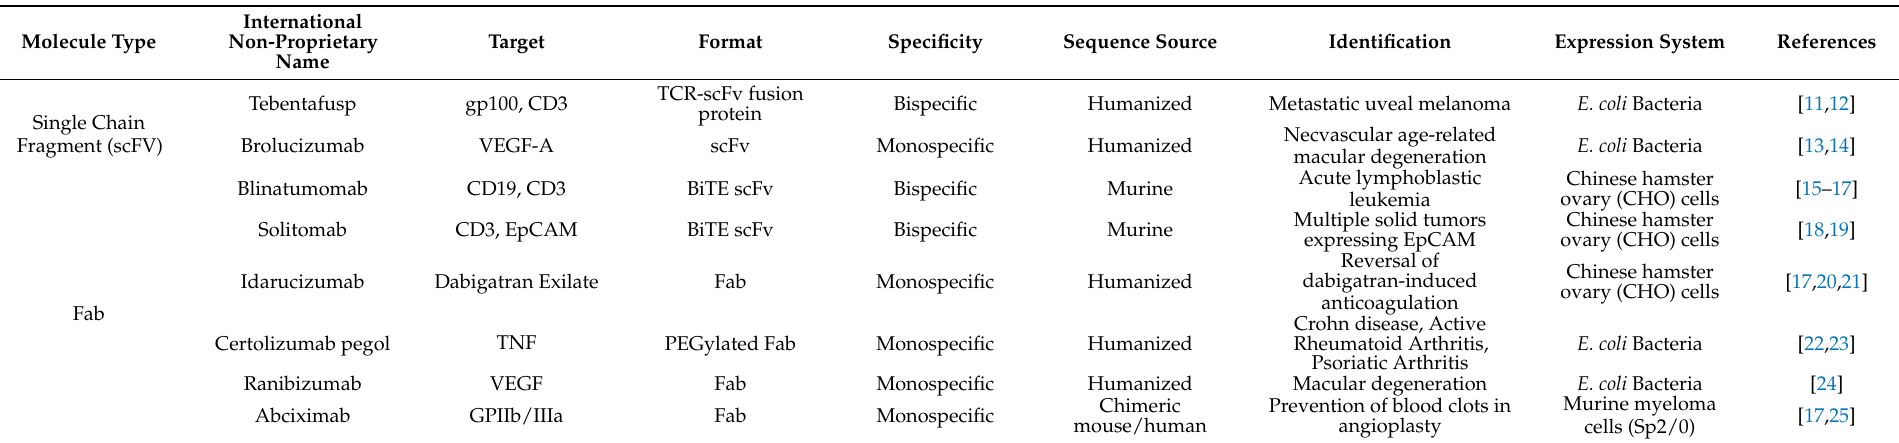
Table 1. List of Fabs and scFvs used in the clinic (or late stage of clinical development) with their specificity, targets and expression